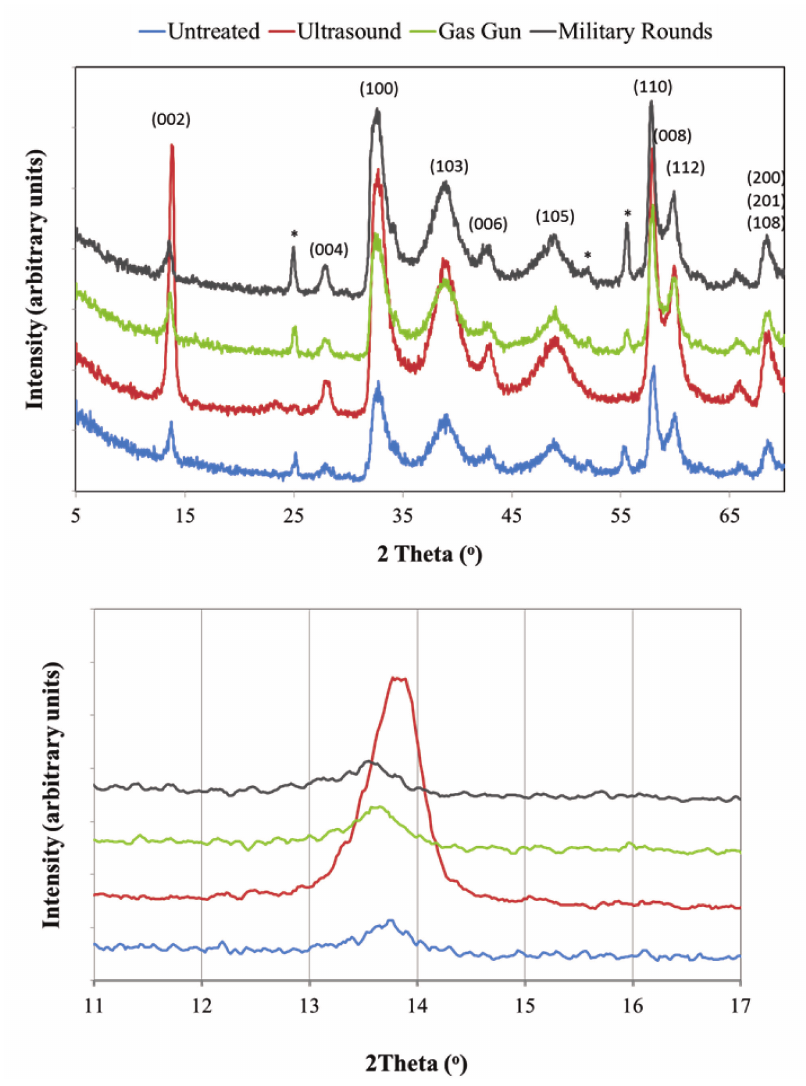
Figure 2. X-ray diffraction analysis of particulates recovered after treatments. Top : reflections observed between 5° and 70°; Bottom : (002) peak for all samples. Only the sample gathered after ultrasonic treatment showed a shift to higher angles. The symbol * identifies a WO 3